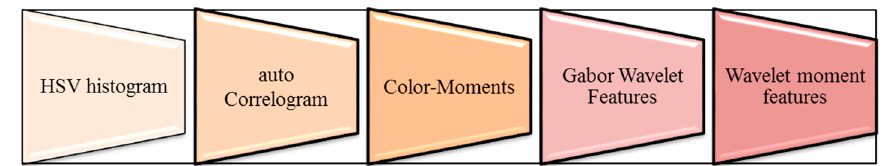
Figure 4. Series of transformation steps.